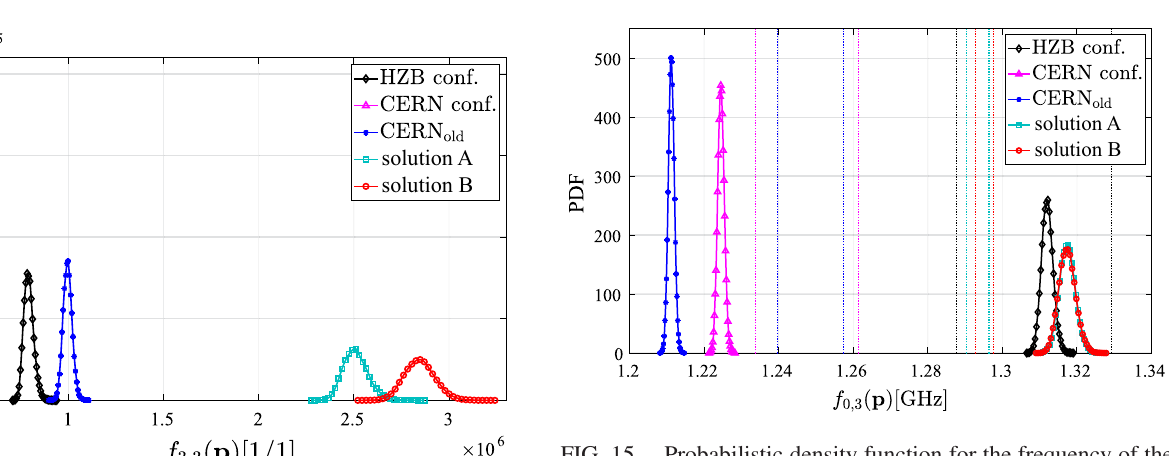
FIG. 15. Probabilistic density function for the frequency of the third operating mode. The dashed vertical lines show the location of the next two closest neighboring modes calculated for the mean values given in Table